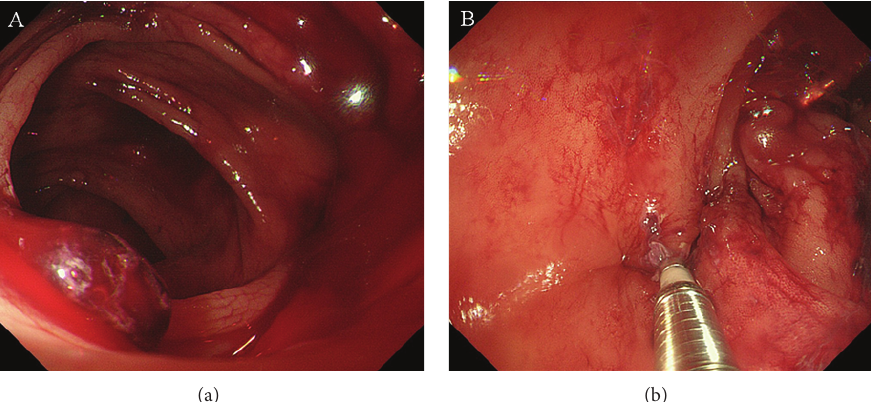
Figure 1: Colonic diverticular bleeding in the hepatic flexure on colonoscopy. (a) Stigmata of recent hemorrhage. (b) Endoscopic treatment using hemoclips.